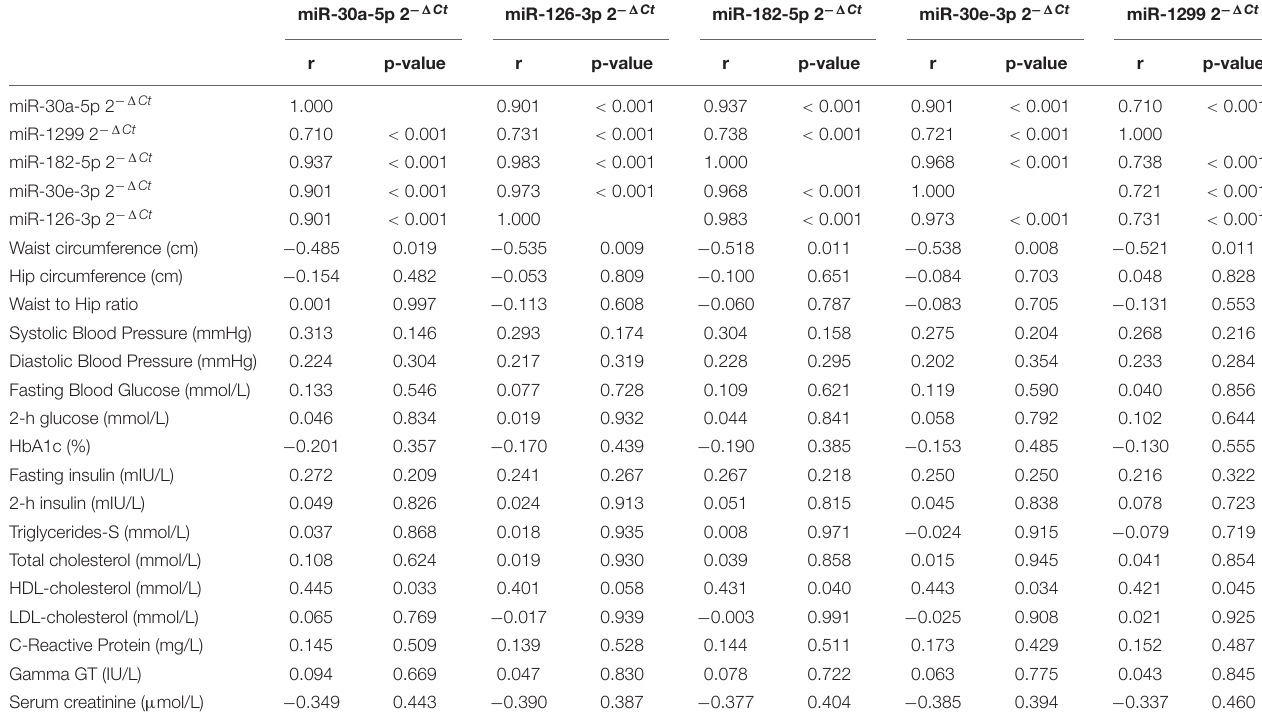
TABLE 2 | Partial correlations between miRNA relative expression and anthropometric and biochemical